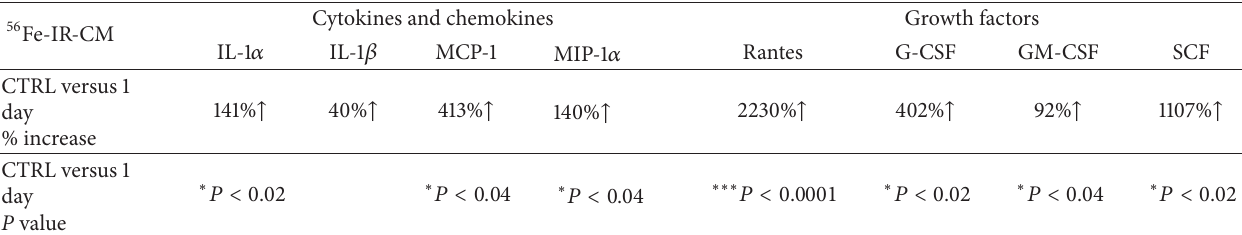
Table 2: Represents % change and statistical significance values in cumulative levels of cytokine, chemokine, and growth factors collected 24 h after treatment with 56 Fe-IR-CM, for control versus day 1.